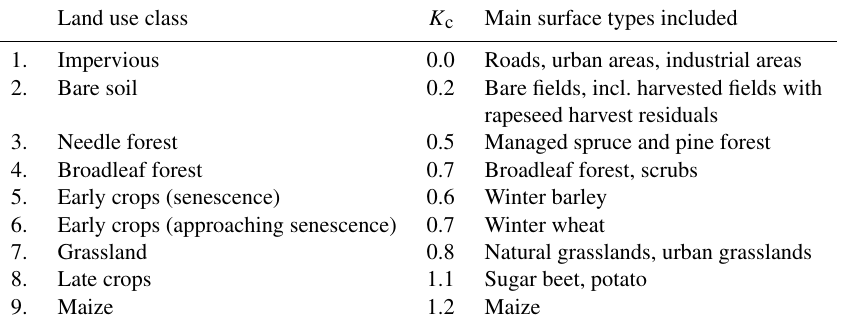
Table 4. Estimated K c coefficients for different land use classes that are dominant in the study area. The land use classes were calculated using a more detailed land use classification that consisted of 32 classes. For this study several classes that have similar transpiration rates were combined.